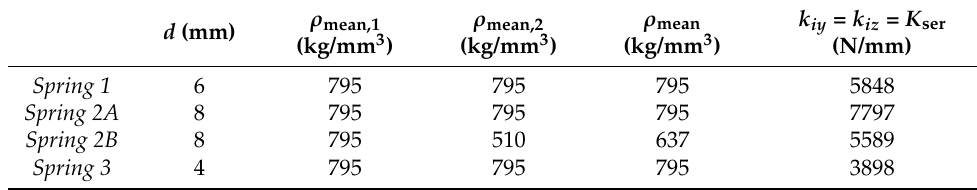
Table 3. Stiffness of the springs.